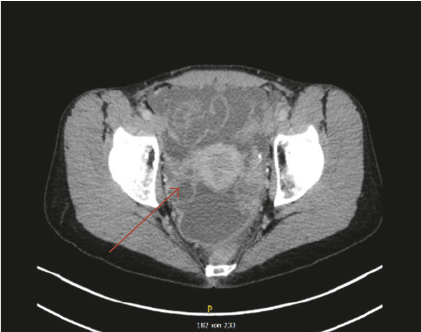
Figure 3: Foaming lavage, easily bloody after contact.